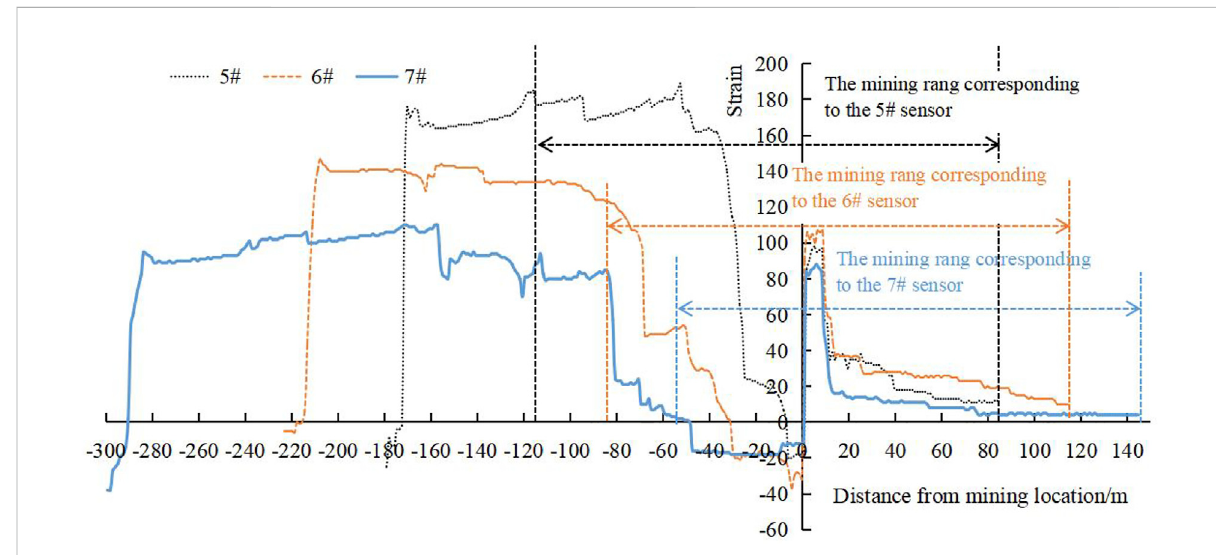
FIGURE 3 Variation curves of strain values of No. 5, No. 6, and No. 7 pressure